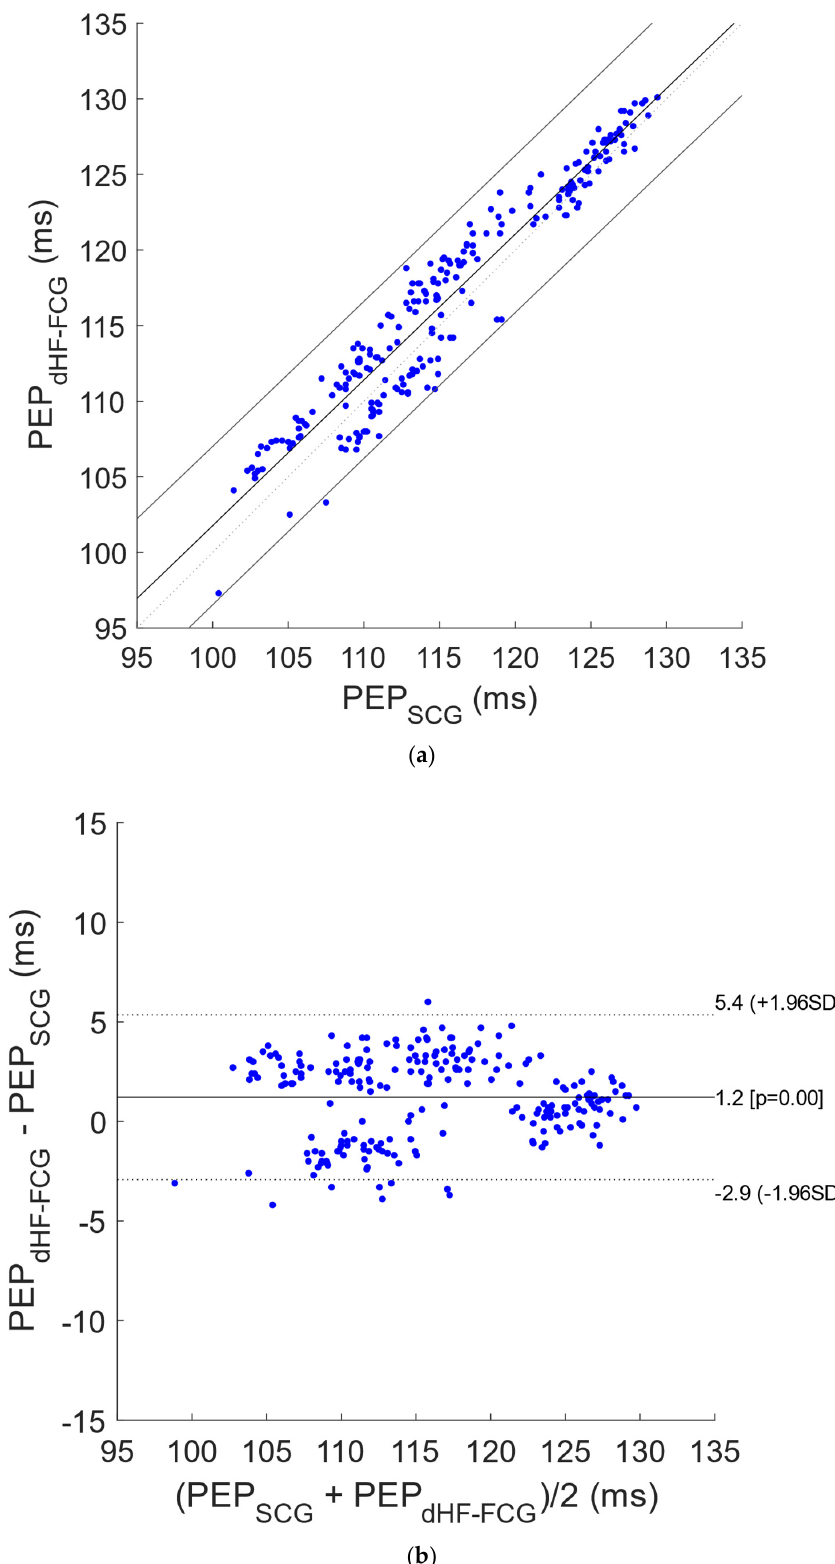
Figure 5. Statistical analyses on PEP estimates related to signals acquired during apneas: ( a ) results of regression and correlation analyses; ( b ) results of Bland–Altman analysis.